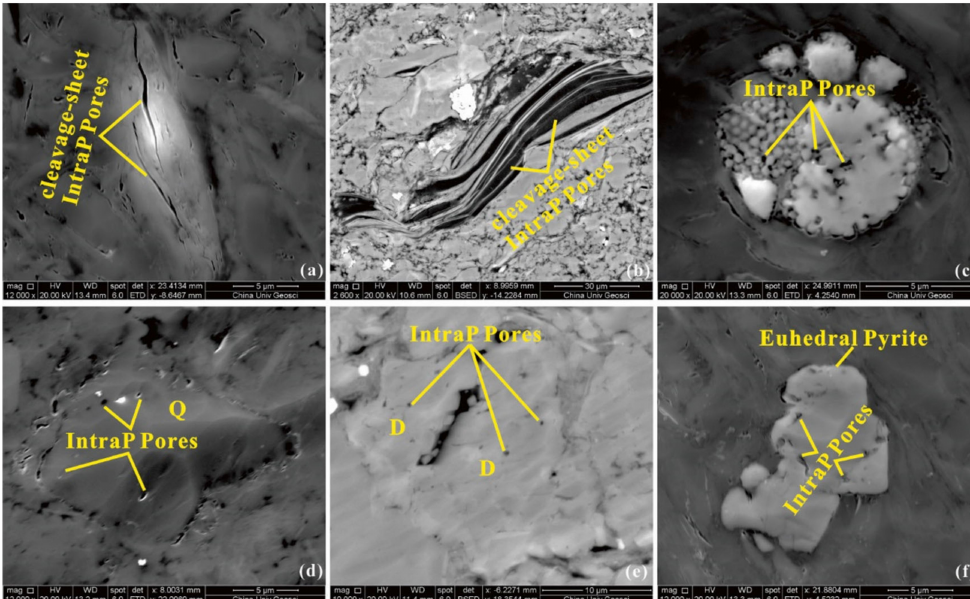
Figure 4. Characteristics of intraparticle pores. ( a , b ) Cleavage-sheet intraP pores within clay minerals; ( c ) IntraP pores within framboidal pyrite; ( d – f ) Corrosion intraP pores developed within quartz (Q), dolomite (D) and euhedral pyrite,